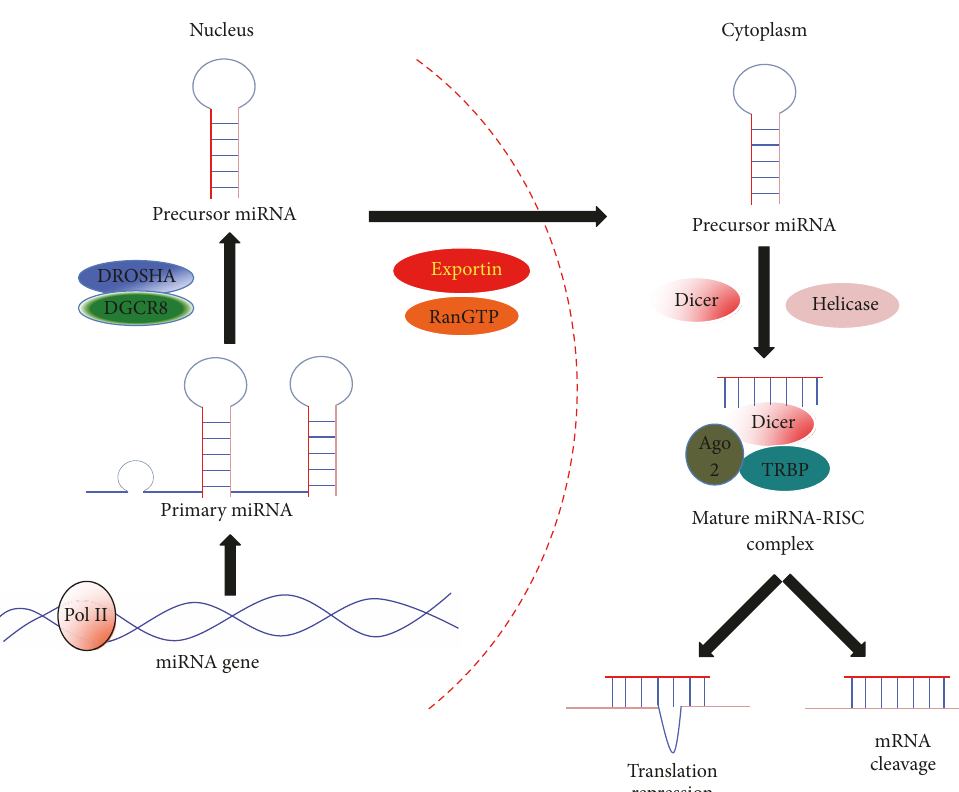
Figure 1: A schematic diagram showing miRNA biogenesis and miRNA-mediated target mRNA suppression. The primary miRNAs (pri- miRNA) are transcribed from miRNA genes by RNA polymerase II or III in the nucleus and subsequently processed by Drosha and DGCR8 to form precursor miRNA (pre-miRNA). Next, the pre-miRNAs are exported into cytoplasm by exportin 5 and RanGTP. In the cytoplasm, the pre-miRNAs are further cleaved by Dicer and resulted in two ssRNAs. Finally, the ssRNAs integrate into RISC protein complex which includesArgonaute2,Dicer,andTRBP.Functionally,themiRNA-RISCcomplexinhibitstargetmRNAexpressionthrougheithertranslational repression or mRNA